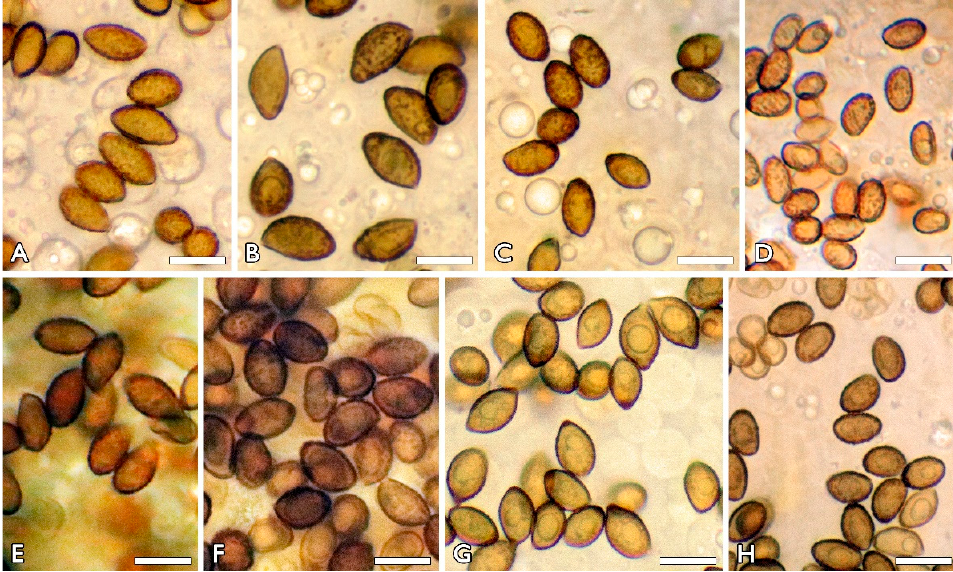
Figure 2. Basidiospores of some Cortinarius s.l. species new to Romania: ( A ) C. catharinae C089